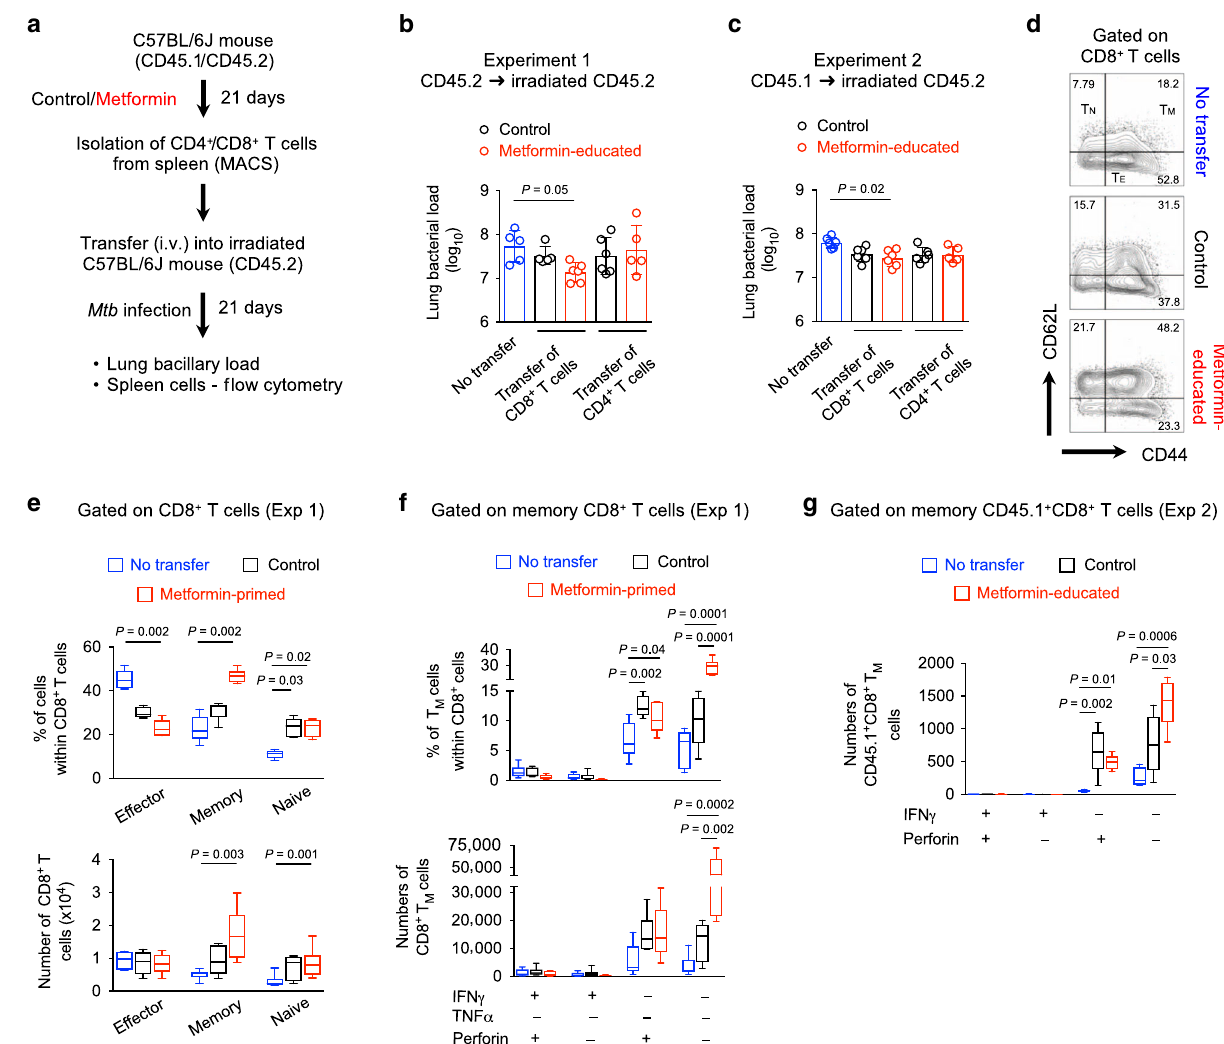
Fig. 1 Metformin-educated CD8 + T cells protect against M. tuberculosis . a Experimental strategy and assessed readouts. b , c Bacterial load in the lung of recipient mice 21 days post transfer, from two different experiments. No transfer — Irradiated recipients that did not receive any cells. Metformin- educated — CD4 + or CD8 + cells from donor mice treated with metformin; Control — cells from untreated mice. n = 5 – 6 mice/group/experiment. d Flow cytometric analysis of splenic CD8 + T cells from mice of experiment 1 b . T M - memory T cells, CD44 + CD62L + ; T E effector T cells, CD44 + CD62L − ; T N - naive T cells, CD44 − CD62L + . e Frequency and number of CD8 + T E , T M , and T N cells in the recipient mice of experiment 1. n = 5 mice/group. f Frequency and number of IFN γ + , TNF + , or Perforin + CD8 + T M cells from e . n = 5 mice/group. g Frequency and number of IFN γ + and/or Perforin + CD45.1 + CD8 + T M cells in the recipient mice of experiment 2. n = 5 mice per group. Box-and-whisker plots show the median, 5 and 95 percentiles. All data are analyzed using Kruskal – Wallis test with Dunn ’ s multiple